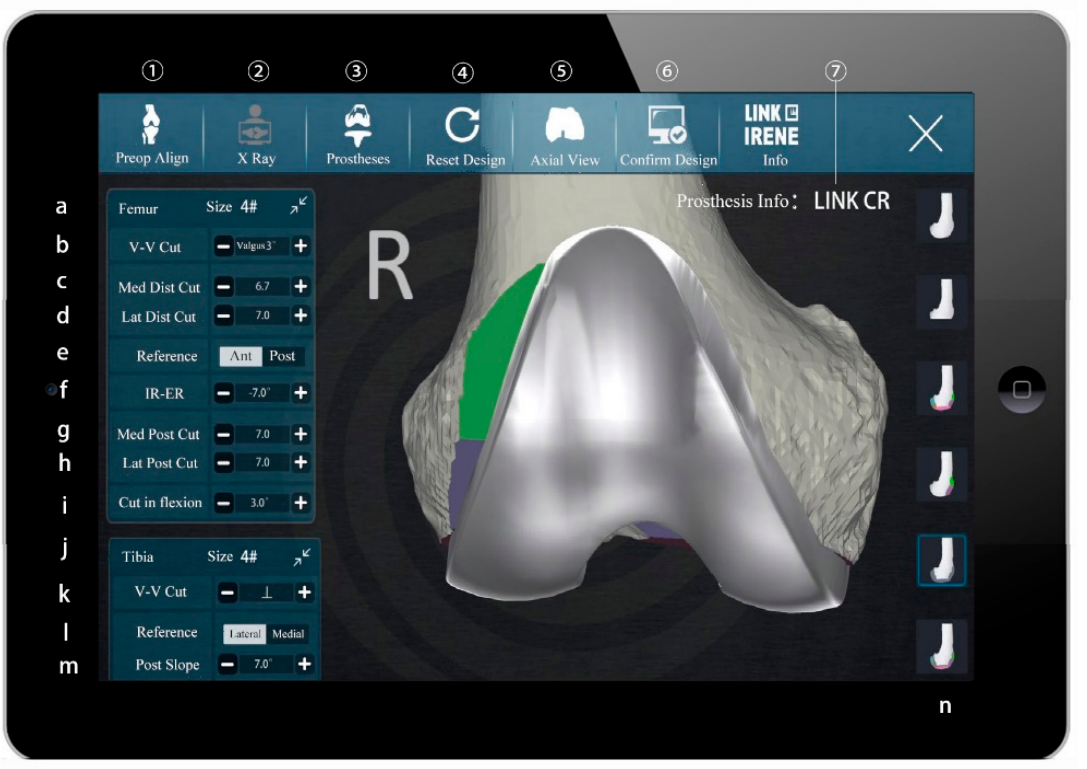
Figure 2. The main working page of EZguide TM application. The interactive buttons in the left sidebar: a femoral component sizing, b Varus-Valgus resection angle of the distal femur with reference to the mechanical axis of the femur (deg.), c resection of medial distal femoral condyle (mm), d resection of lateral distal femoral condyle (mm), e anterior or posterior referencing, f femoral Internal-External rotation angle in axial plane with reference to trans-epicondylar axis (deg.), g resection of medial posterior femoral condyle (mm), h resection of lateral posterior femoral condyle (mm), i flexion angle of femoral component in sagittal plane with reference to the mechanical axis of the femur (deg.), j tibial component sizing, k Varus-Valgus resection of proximal tibia on the coronal plane with reference with the mechanical axis of tibia (deg.), l medial or lateral tibial resection reference, m tibial posterior slope (deg.) and the resection depth of tibial resection (at the bottom of main page, not displayed on the screen, mm). The interactive buttons on the top of screen: ① Preoperative alignment of lower extremities, ② Preoperative radiographs, ③ Available commercial prostheses, ④ Reset the design, ⑤ Axial view, ⑥ Confirm the design, ⑦ Selected prosthesis information. The buttons in the right sidebar provides different visualization options, including intact bone anatomy with key landmarks, the geometry of resection surface, the resected bones in different colors, the coverage of resection surface by prosthesis, and the superimposed bone and prosthesis.